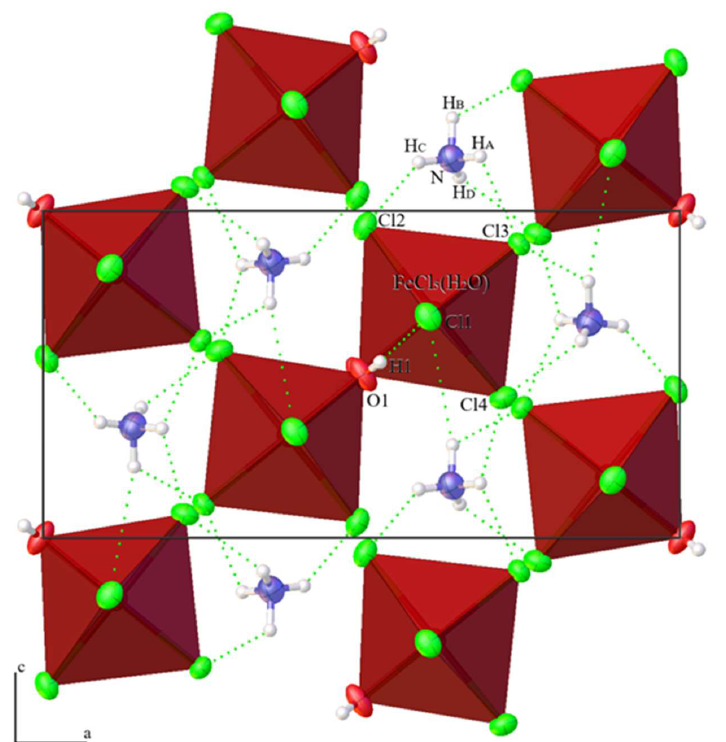
Figure 3. The crystal structure and hydrogen bonding of (NH 4 ) 2 FeCl 5 ·H 2 O phase. Table 9. Hydrogen bonds of NH 4 MgCl 3 ·6H 2 O and (NH 4 ) 2 FeCl 5 ·H 2 O.